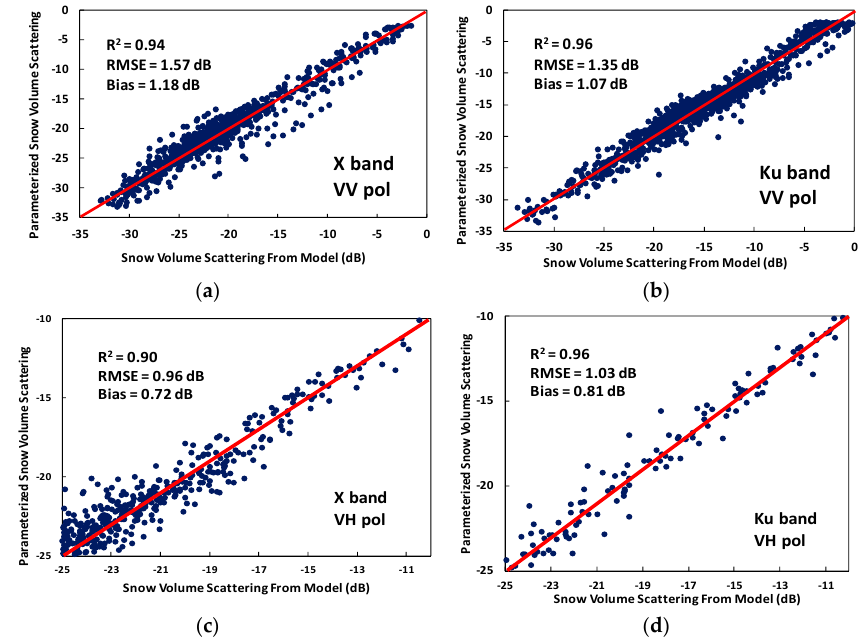
Figure 4. Comparing the simulated snow volume backscattering of X at VV ( a ) and VH ( b ) polarizations; and that of Ku at VV ( c ) and VH ( d ) polarizations with the ones calculated by Equations (7)–(10), respectively.